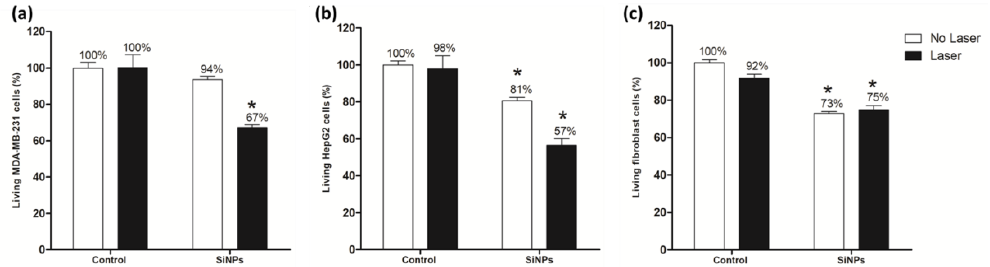
Figure 4. Two-photon excitation PDT effect of SiNPs on MDA-MB-231 cells ( a ), HepG2 cells ( b ) and fibroblast cells ( c ) treated with 50 µg mL −1 of NPs for 24 h. Cells were irradiated with pulsed laser at 900 nm (3 scans × 1.57 s). Data are presented as (mean ± SEM) of two independent experiments realized in triplicate. * Statistical significance ( p < 0.05) for SiNPs laser versus control no laser (student’s t -test).